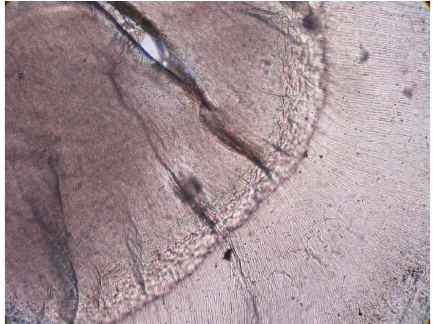
Figure 4: Presence of lamellae, spindles and tufts (photomicro- graph, ground section